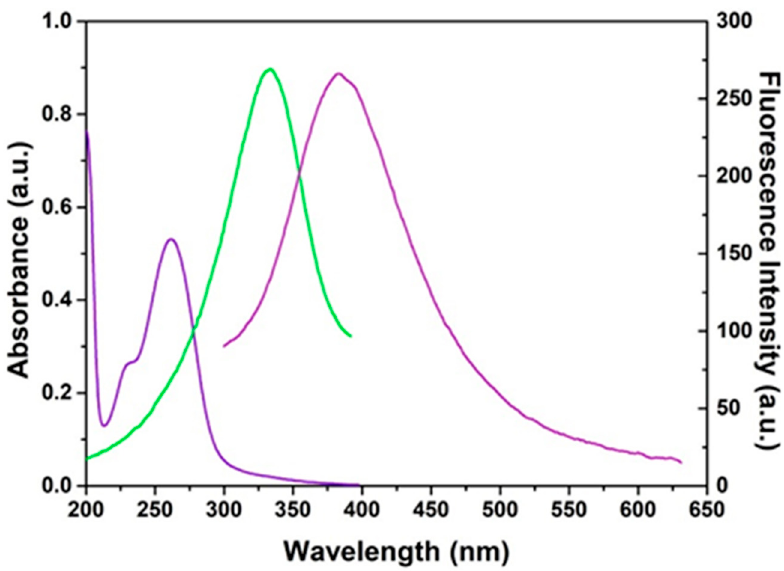
Figure 5. UV–Vis absorption spectra of N-CQDs stock solution ( left , violet), excitation spectrum (green), and fluorescence ( right , violet).